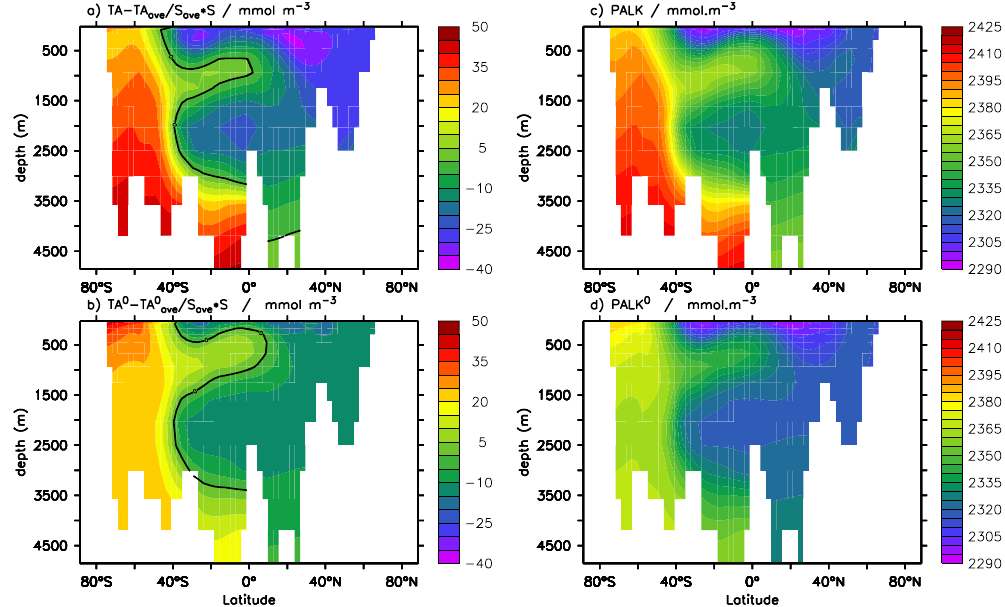
Figure 6. Anomalies of TA (a) and TA 0 (b) and the respective salinity normalized properties. (c) Potential alkalinity PALK = (ALK + PO 4 · 16 )/S · 35 distribution along a section through the Atlantic. (d) Potential preformed alkalinity PALK 0 = ( TA 0 + PO 40 · 16 )/S · 35. The distribution along 30 ◦ W from a model run (TMM-MIT28, see Sect. 4 for details of the model experiments) is